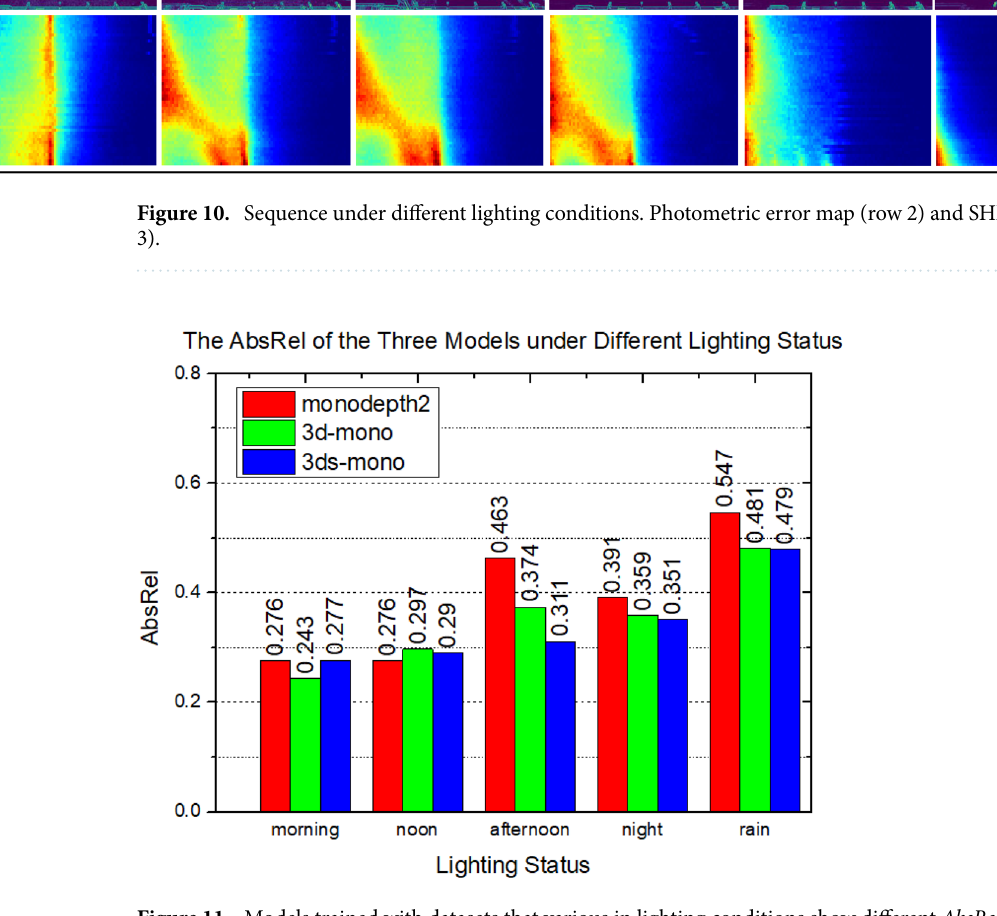
Figure 11. Models trained with datasets that various in lighting conditions show different AbsRel